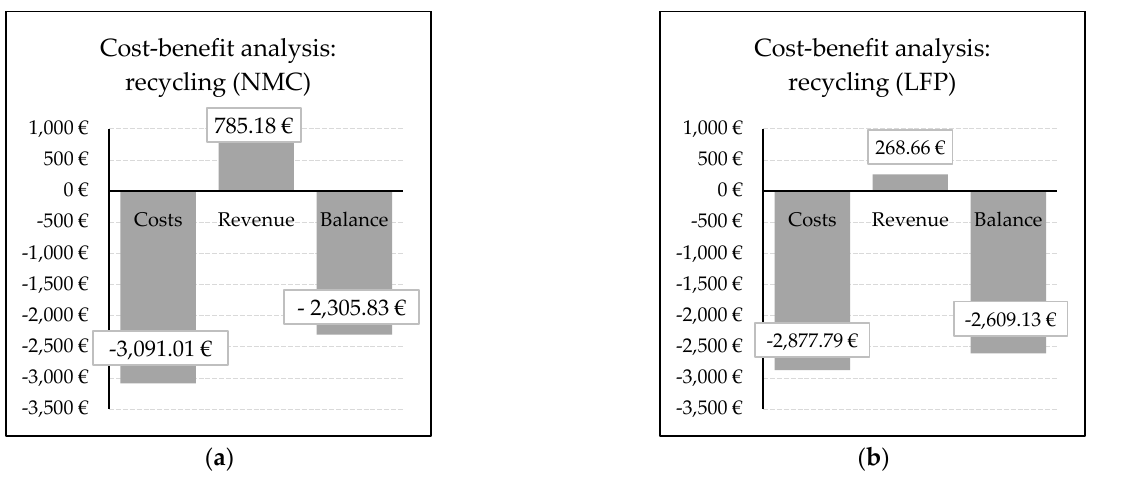
Figure 11. Cost – benefit analysis for the recycling business case related to a processed battery pack using ( a ) NMC cathodes and ( b ) LFP cathodes (non-scaled state-of-the-art process design).